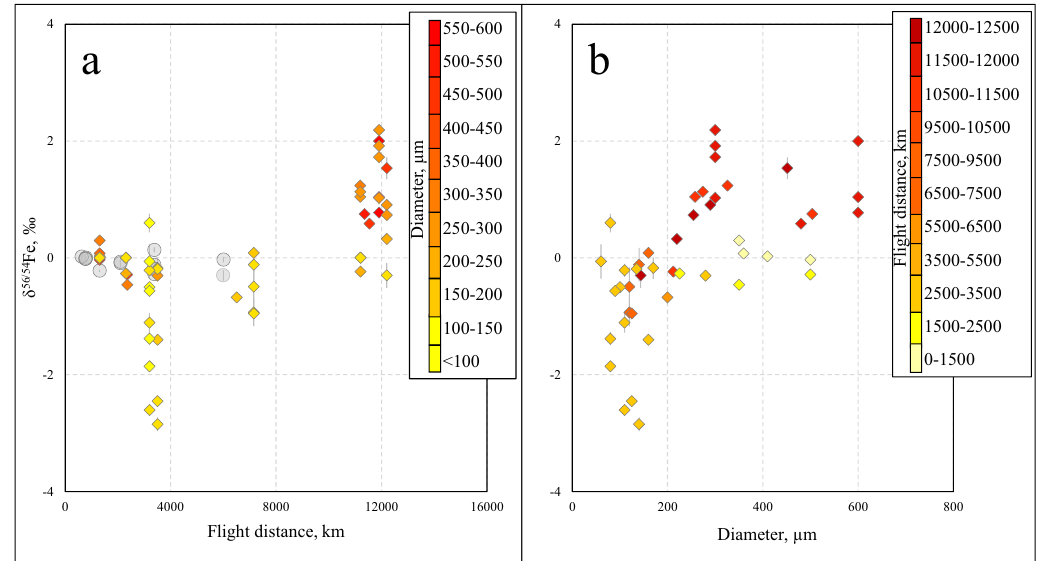
Fig. 3 Relations between Fe isotopic signatures, distance, and size. a - Fe isotopic signatures of the Australasian microtektites versus their distance to the hypothetical crater location. b – Fe isotopic signatures of the microtektites versus their diameter. Macroscopic tektites are shown using gray